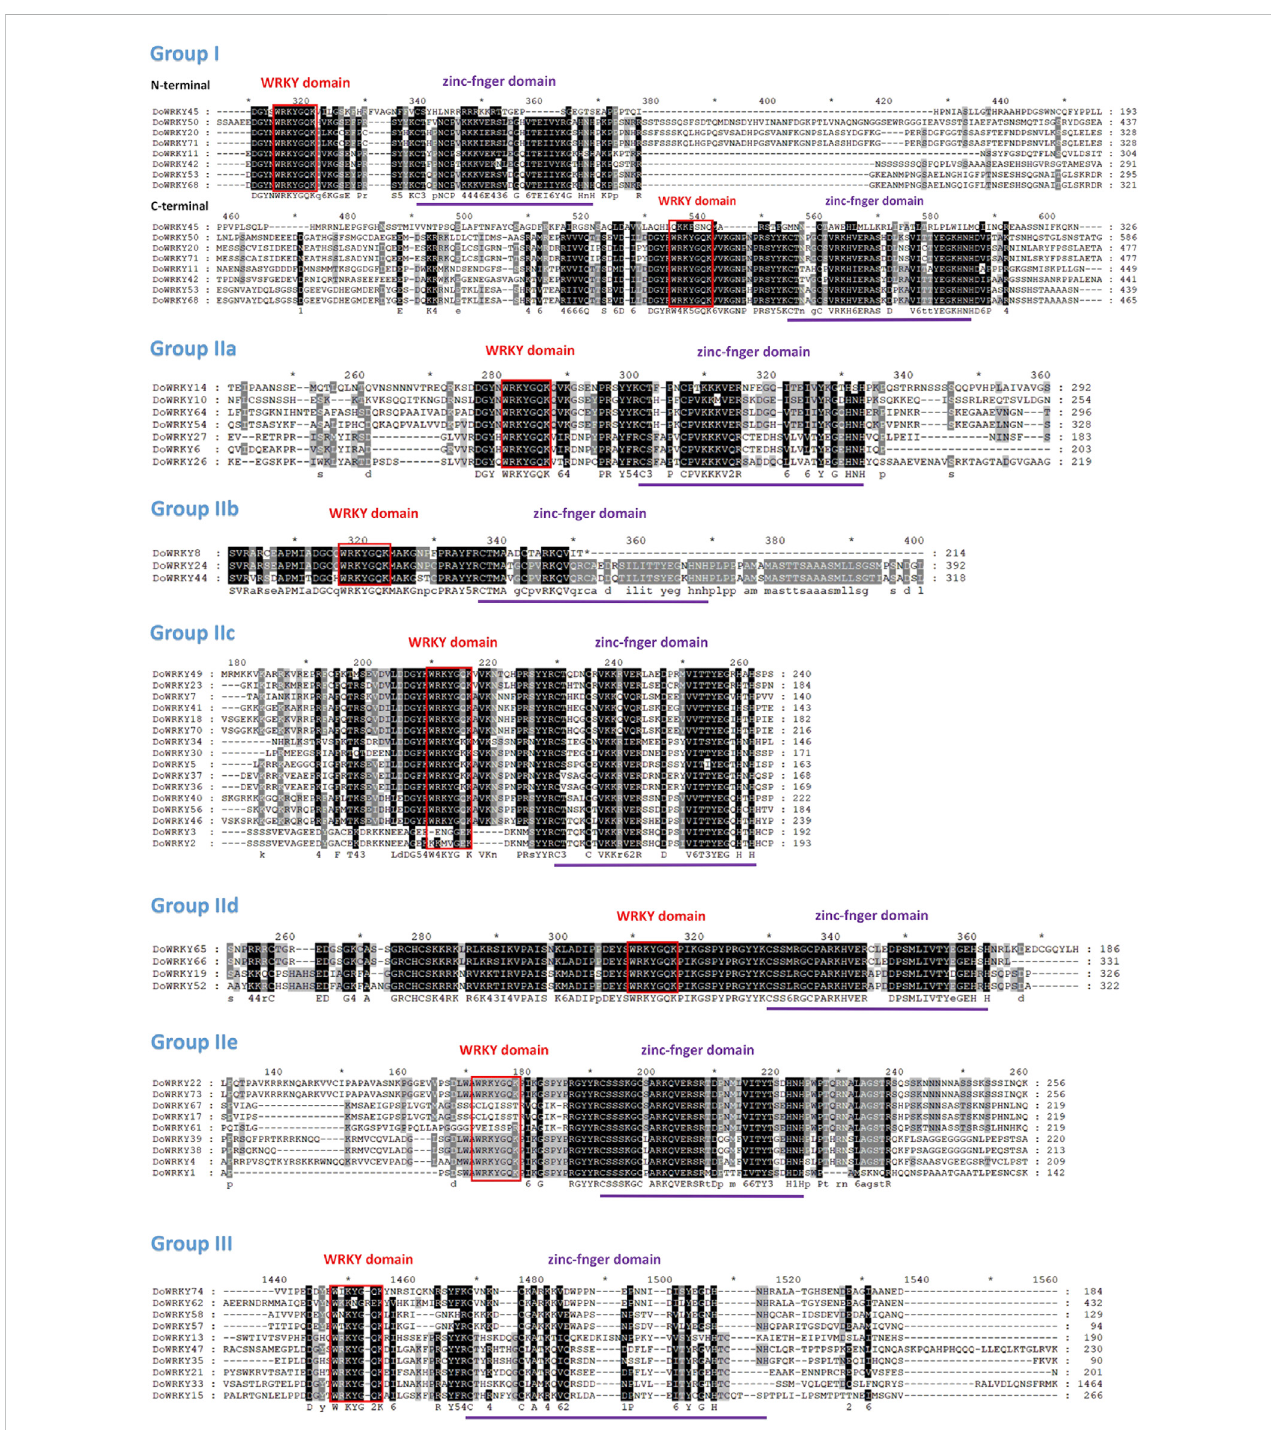
MultiplesequencealignmentoftheWRKYdomainamongDoWRKYproteins.RedindicatesconservedWRKYdomains.Purpleindicateszinc fi ngermotifs and dashes indicate